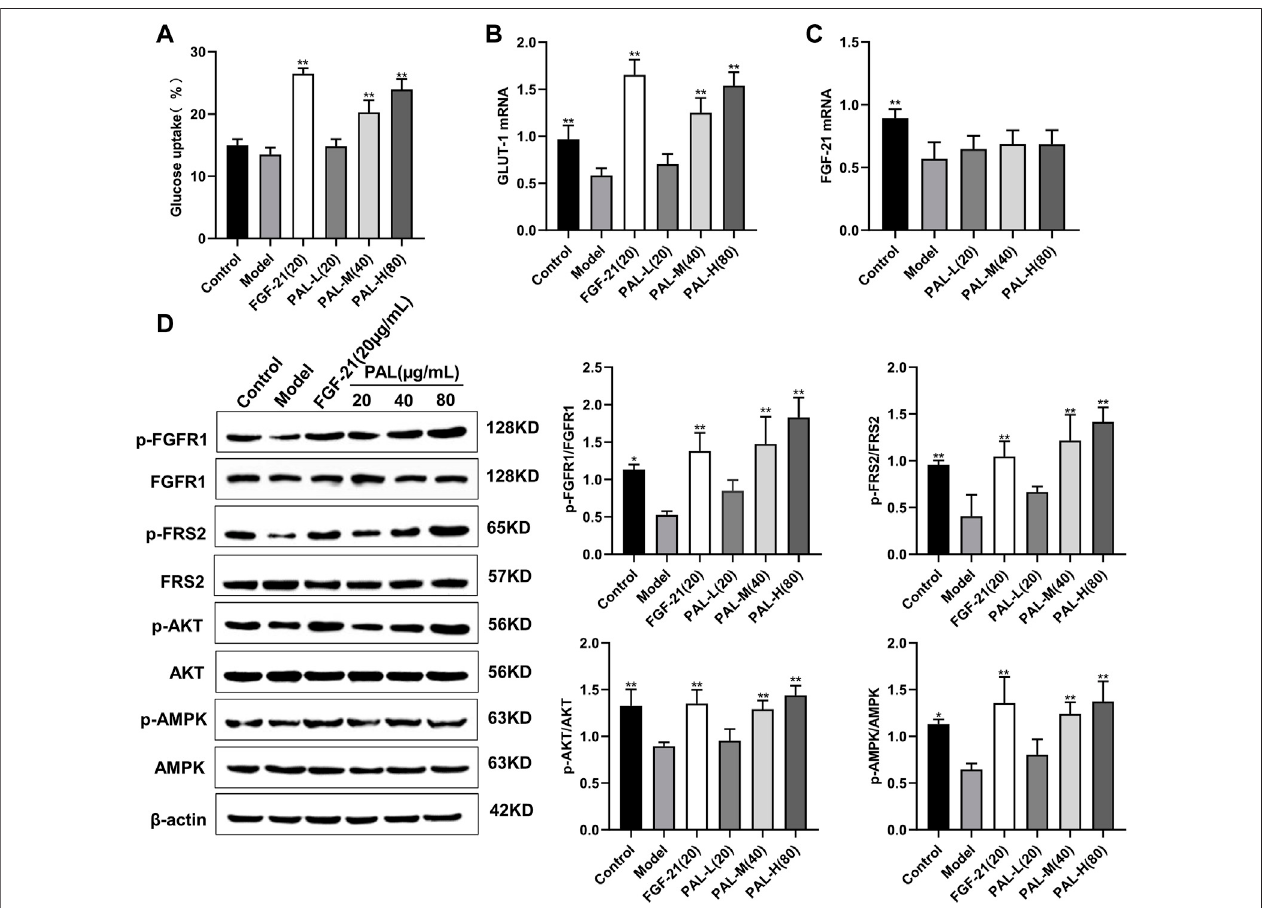
FIGURE4| Theeffect ofpalmatine(PAL)onthe fi broblast growth factorreceptor 1(FGFR1) pathway inIRHepG2cells. (A) glucose uptakebyIRHepG2cellsafter PALtreatment. (B) therelativemRNAlevelofglucosetransportertype1(GLUT-1)inIRHepG2cellsofeachgroup. (C) therelativemRNAlevelofFGF21inIRHepG2cells of each group. (D) quantitative analysis of the expression levels of p-FGFR1 and FGFR1 (p-FGFR1/total FGFR1), p-FRS2 and FRS2 (p-FRS2/total FRS2), p-AKT and AKT (p-AKT/total AKT),and p-AMPK and AMPK(p-AMPK/totalAMPK)usingwesternblot. Dataarepresented asmeans±SD, n =9. * p < 0.05, ** p < 0.01, versus the model